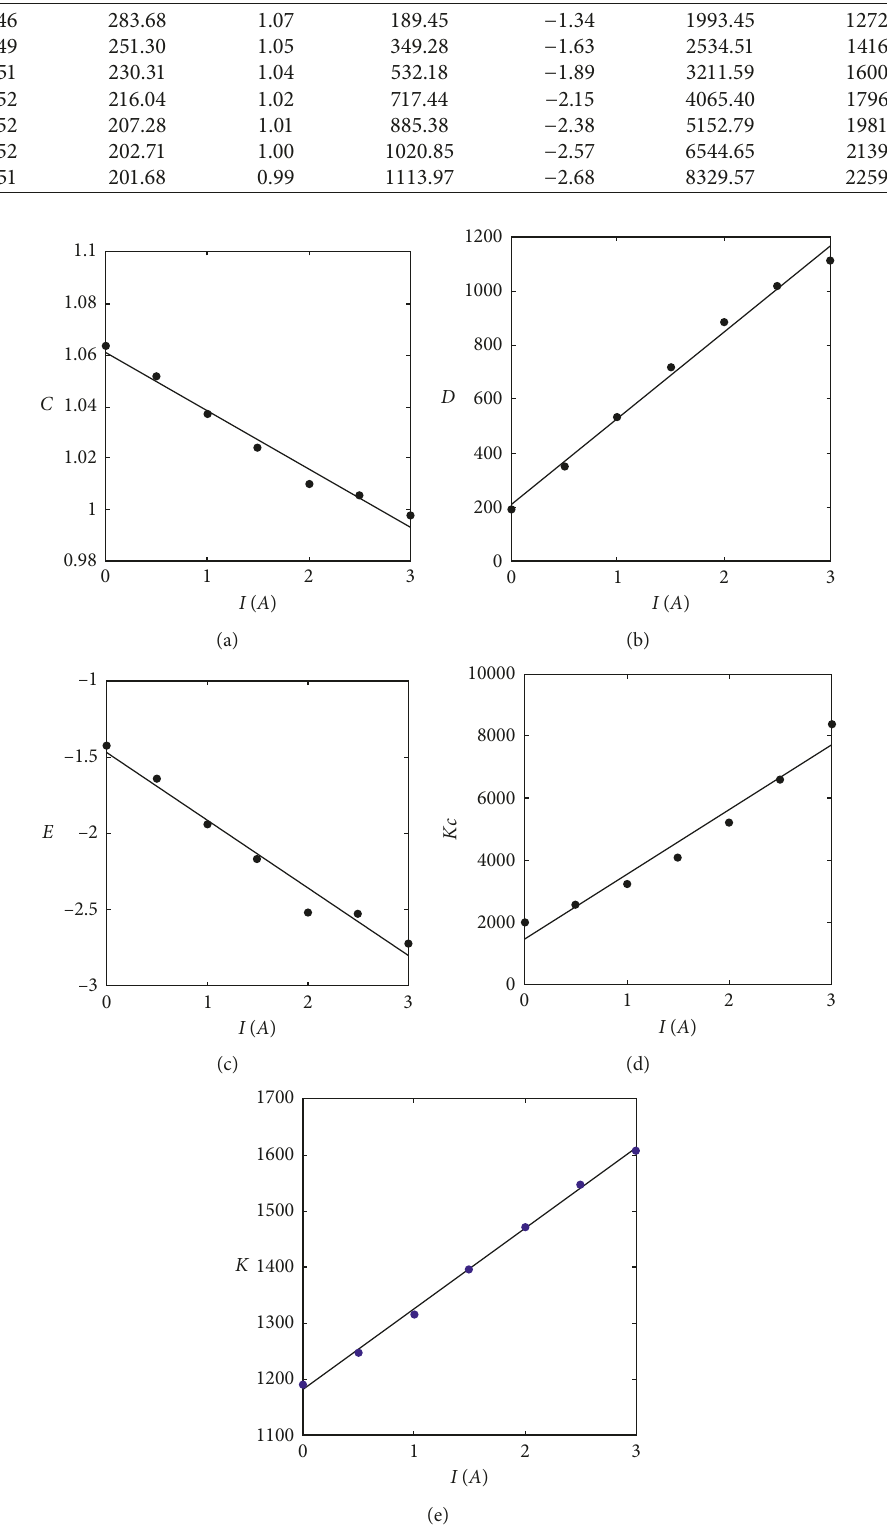
Figure 6: Parameter C , D , E , k k and current fit graph. The points represent the experimental values, and the line represents the fitted c , and value. (a) Parameter C and current fit graph. (b) Parameter D and current fit graph. (c) Parameter E and current fit graph. (d) Parameter k c and current fit graph. (e) Parameter k and current fit